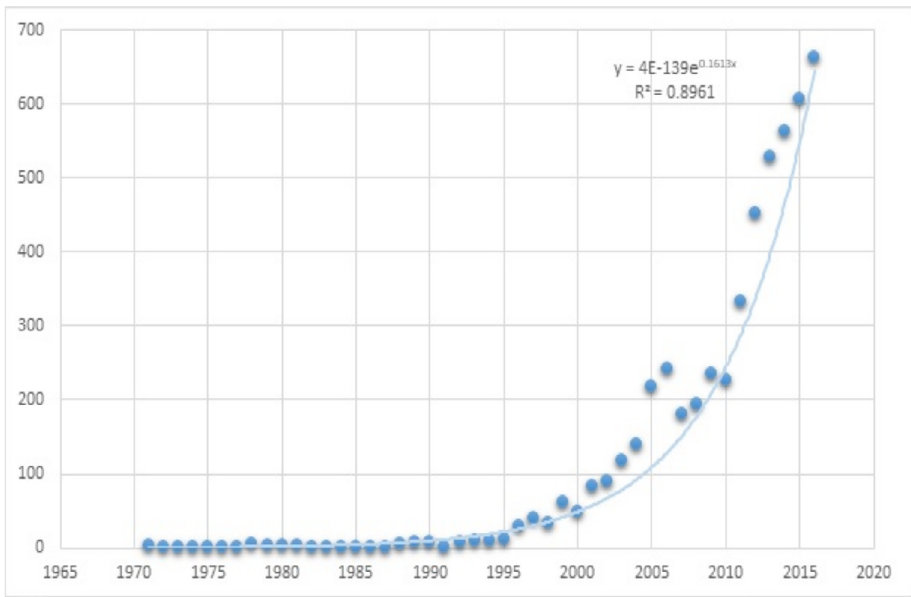
Figure 2: Number of publications by year, with its moving average trendline (1971-2016 in Scopus)